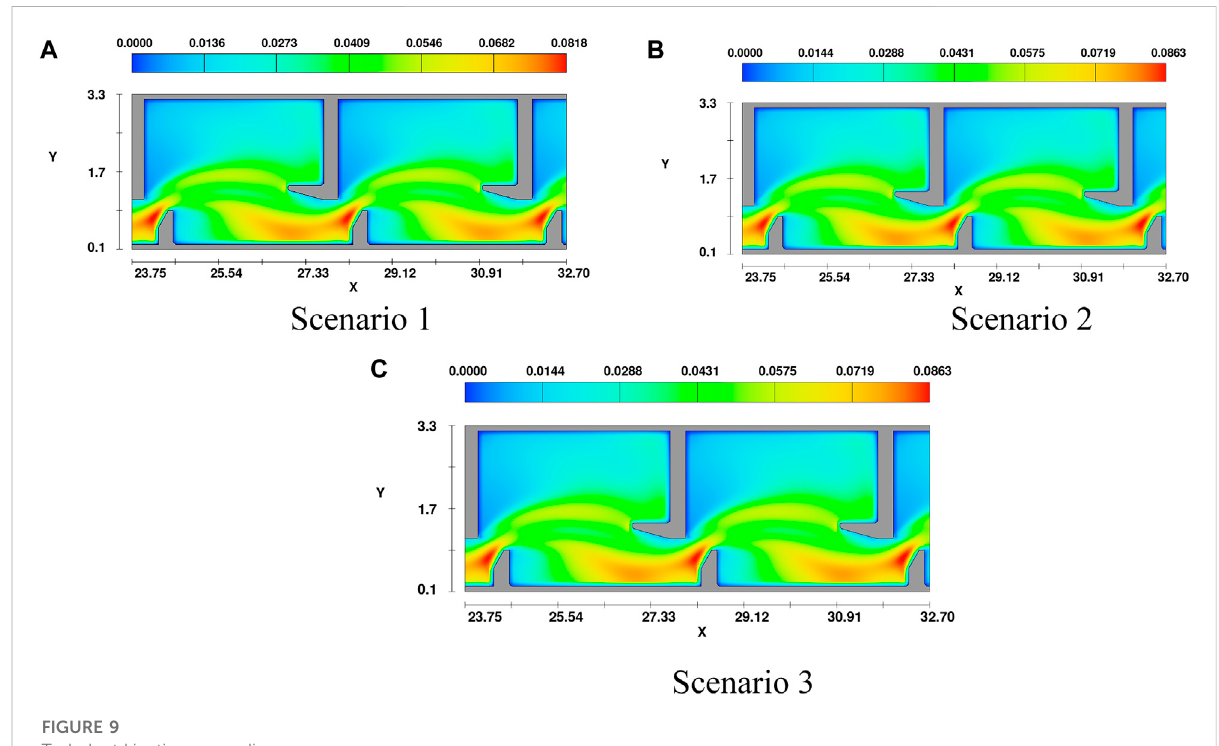
FIGURE 9 Turbulent kinetic energy diagram.